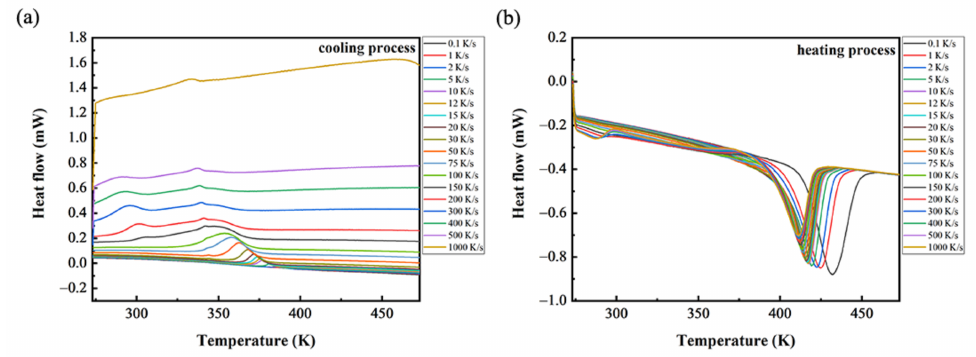
Figure 2. Flash DSC measurements of PP at cooling rates from 0.1 to 1000 K/s: ( a ) cooling process; ( b ) heating process.